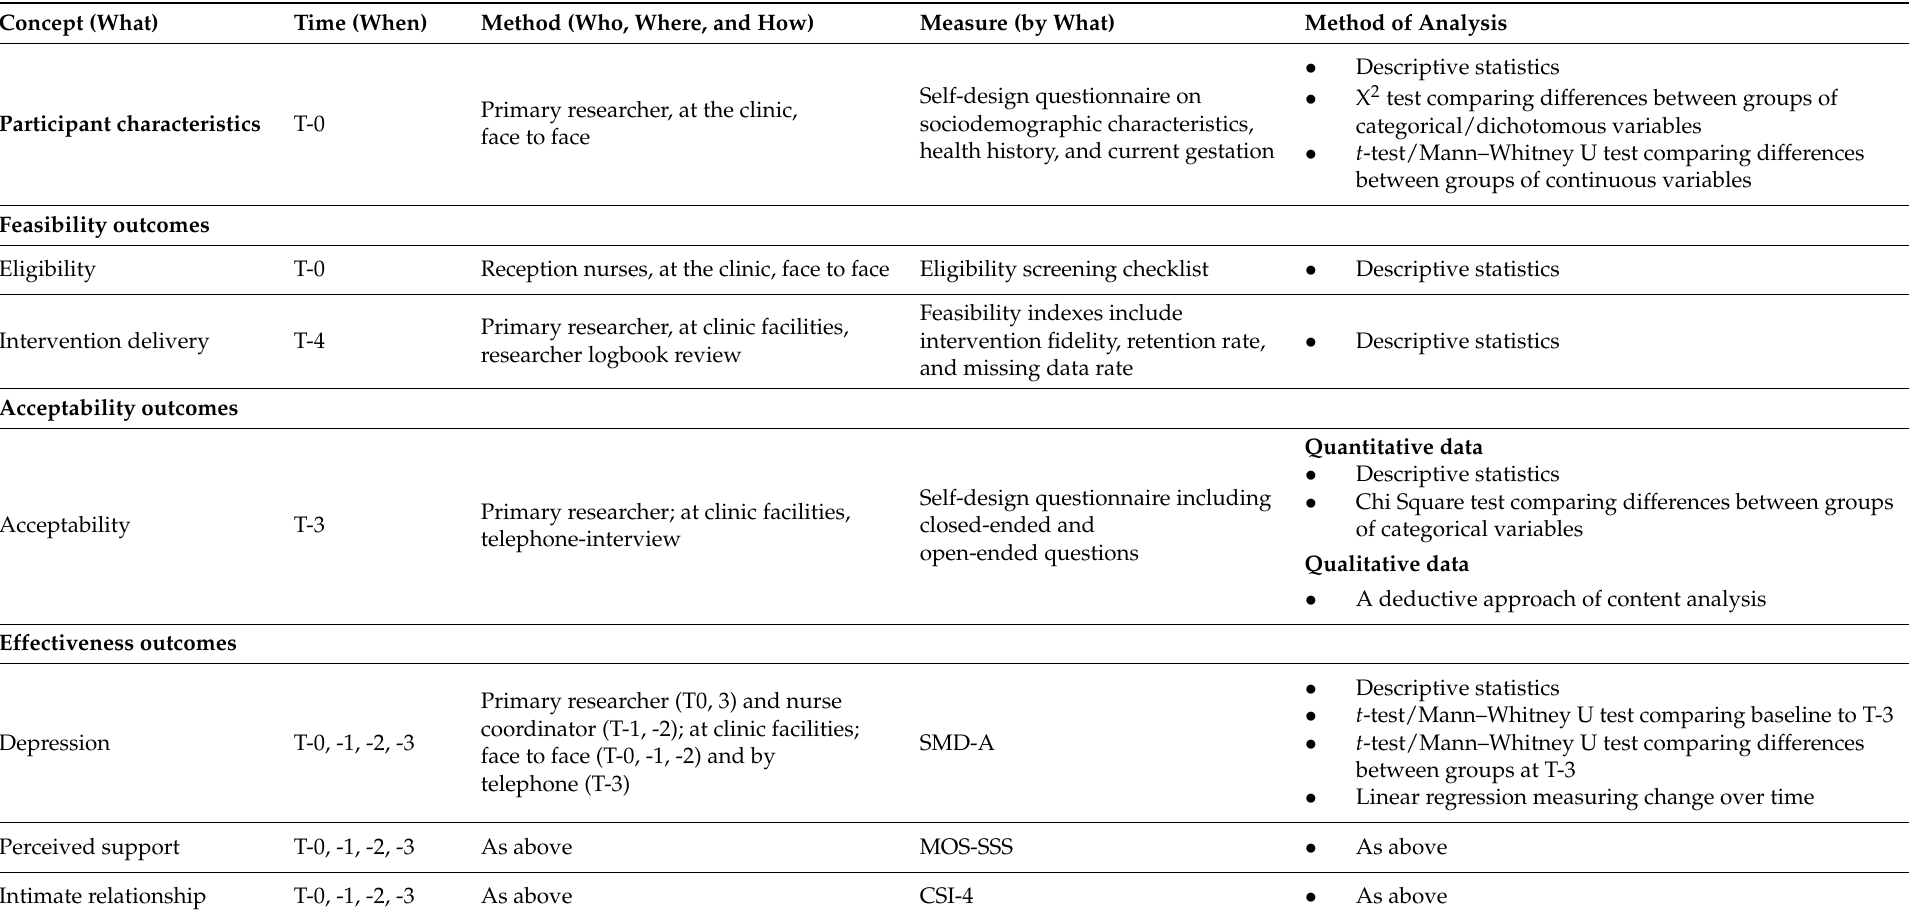
Table 3. Data collection schedule and analysis